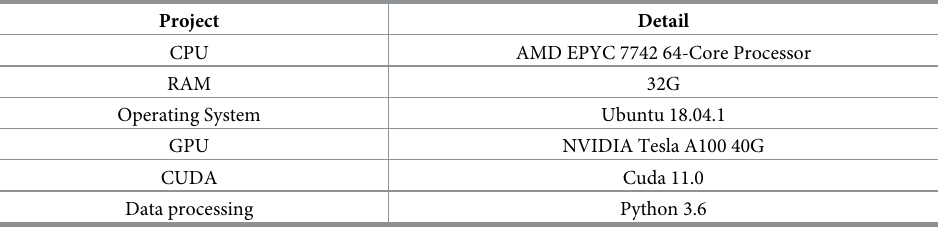
Table 1. Machine software and hardware